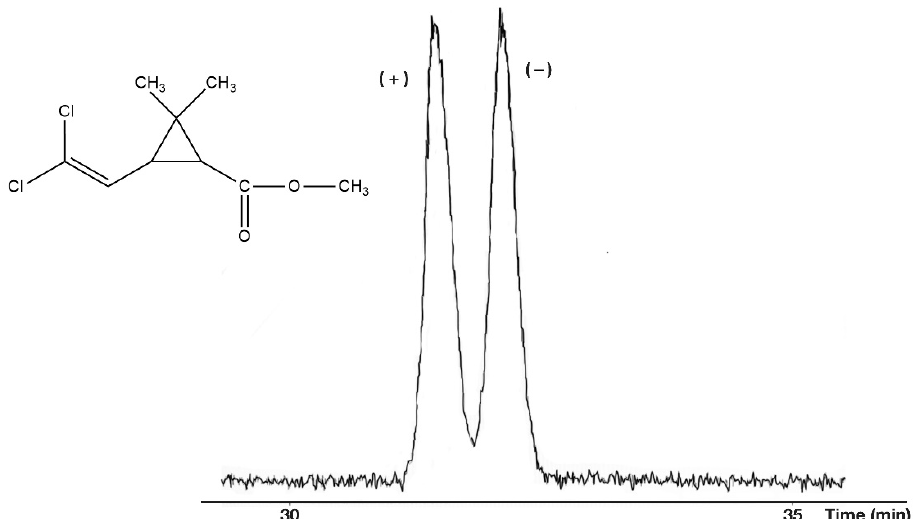
Figure 6. Chiral separation of trans ‐ permethrinic acid methyl ester. Conditions: instrument, Shimadzu GC/MS ‐ QP5000 GC/MS; column, 25 m × 0.22 mm; stationary phase, Cydex ‐ B (0.25 μ m); carrier, He (50 cm/s); temperature, 160 °C. It seems that the hydrogen bond donor ability of the well ‐ positioned acid group of the analytes improves many of their chiral recognitions on several occasions. It is likely that the electrostatic interaction between the H in the acid groups and the H acceptors (the lone electrons of oxygen) of the selectors interact with each other, improving the chiral selectivity. The permethyl alfa cyclodextrin has a chiral recognition feature towards only half of the tested pyrethroic acids. Chiral resolution was not recognized for the tested chrysanthemic compounds. The permethrinic acids are well suited for chiral recognition of permethyl α‐ CD mostly in underivatized forms of the acids. The cis isomers show much higher chiral selectivity than the trans isomers in α‐ CD selectors. The (+) isomers eluted before the ( − ) isomers on every occasion using the Alfa Dex 120 column.